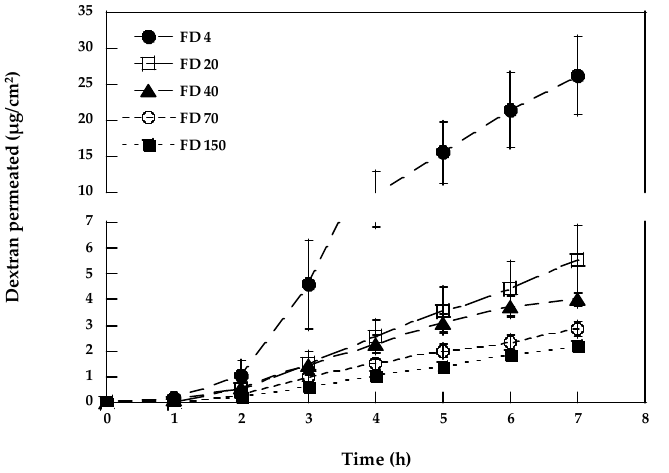
Figure 2. Permeation profiles of dextrans in the presence of 53.77 mg/mL sodium taurocholate (mean values ± SEM).